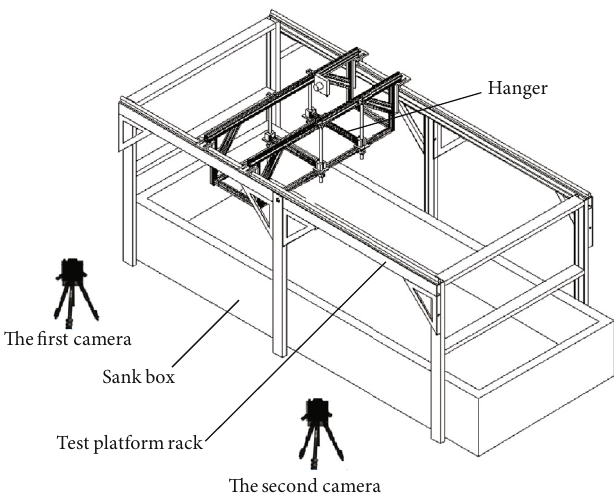
Figure 4: Test platform and camera position distribution diagram.